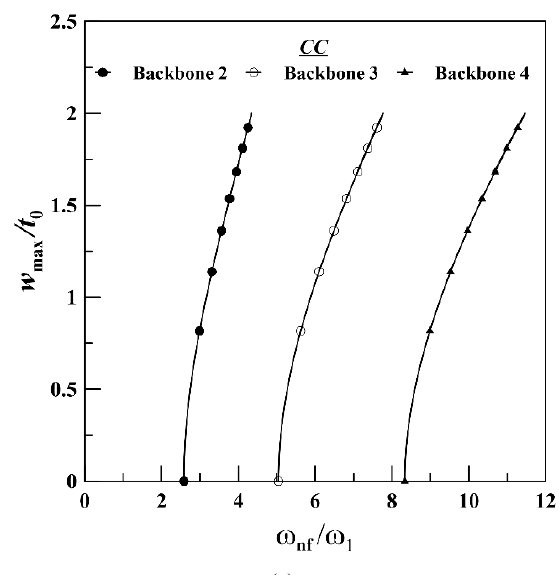
Figure 5. Backbone curves for different values of taper parameter for (a) CC beam, (b) CS beam, (c) SS beam.